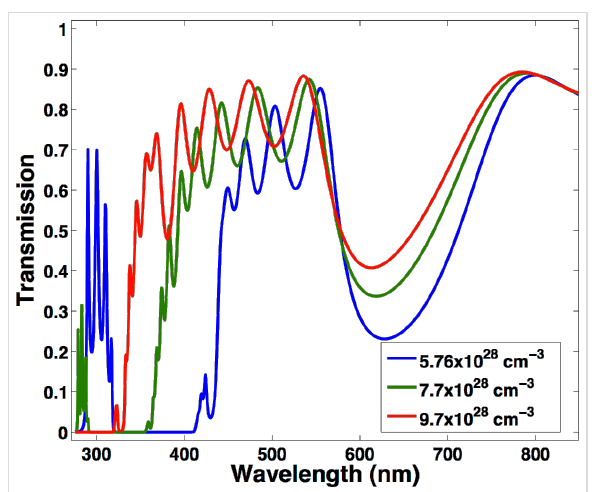
Figure 6: Transmission spectra simulated with the transfer matrix method for a Ag/TiO 2 nanoparticle photonic crystal device with three different carrier